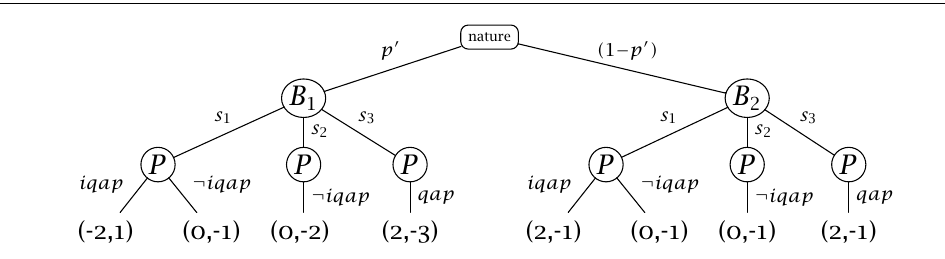
P ’s model of the extended signalling game where B responds to P’s question ( 1 c) and P interprets that response. B Bronston that likes to misdirect P , while B misdirect P . The utilities are given in the order (P, B)